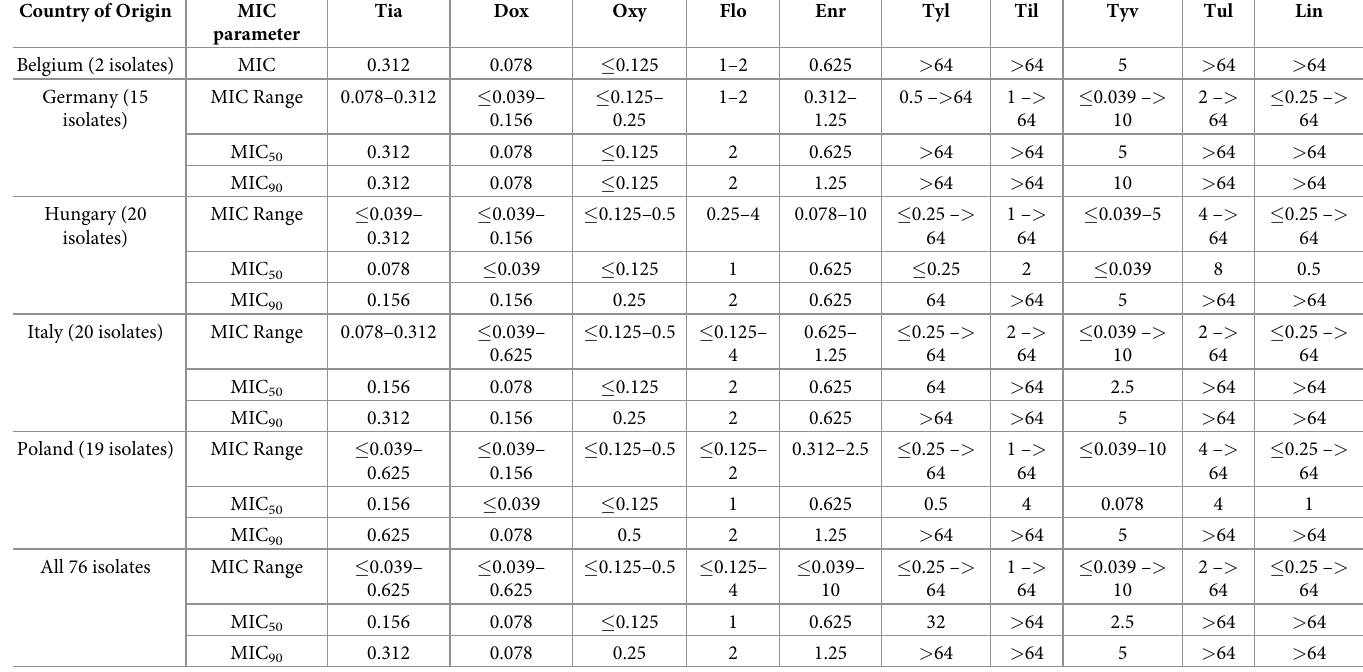
Table 1. Minimal inhibitory concentration (MIC) values of ten antimicrobial agents against 76 Mycoplasma hyorhinis isolates. Total values and values for each coun- try are given.